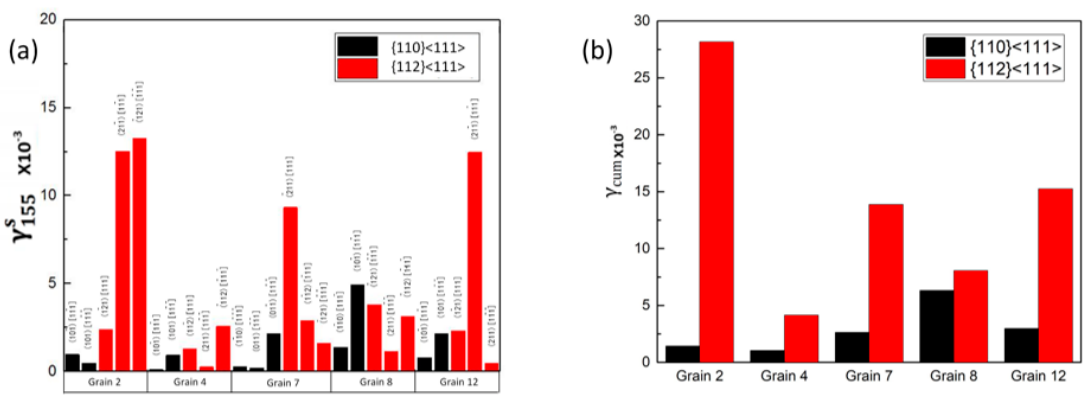
γ γ 155 and ( b ) cum of slip systems of different grains in β phase at macro strain s